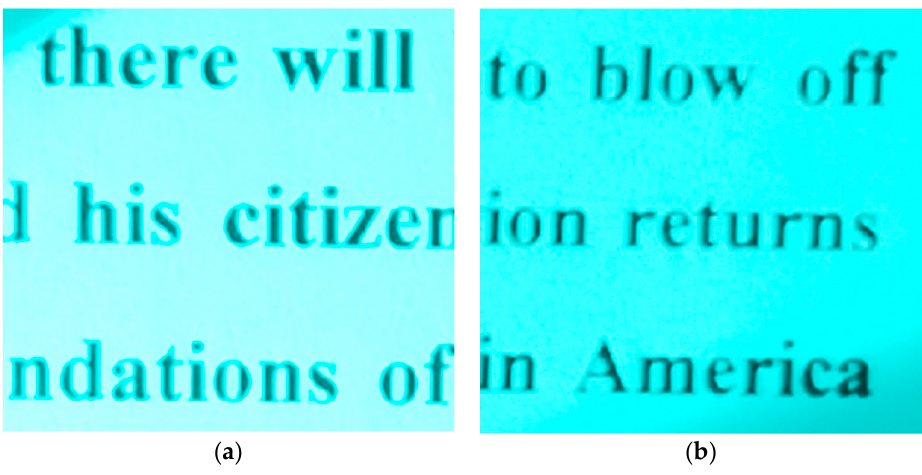
Figure 7. Pseudo color image composed of registered Figure 1(a),(c). The green and blue bands come from the green and blue bands of the registered well-exposed image while the red band is from the red band of the registered over-exposed image. ( a ) The small image patch from the left central part of the pseudo color image. ( b ) The small image patch from the right central part of the pseudo color image.